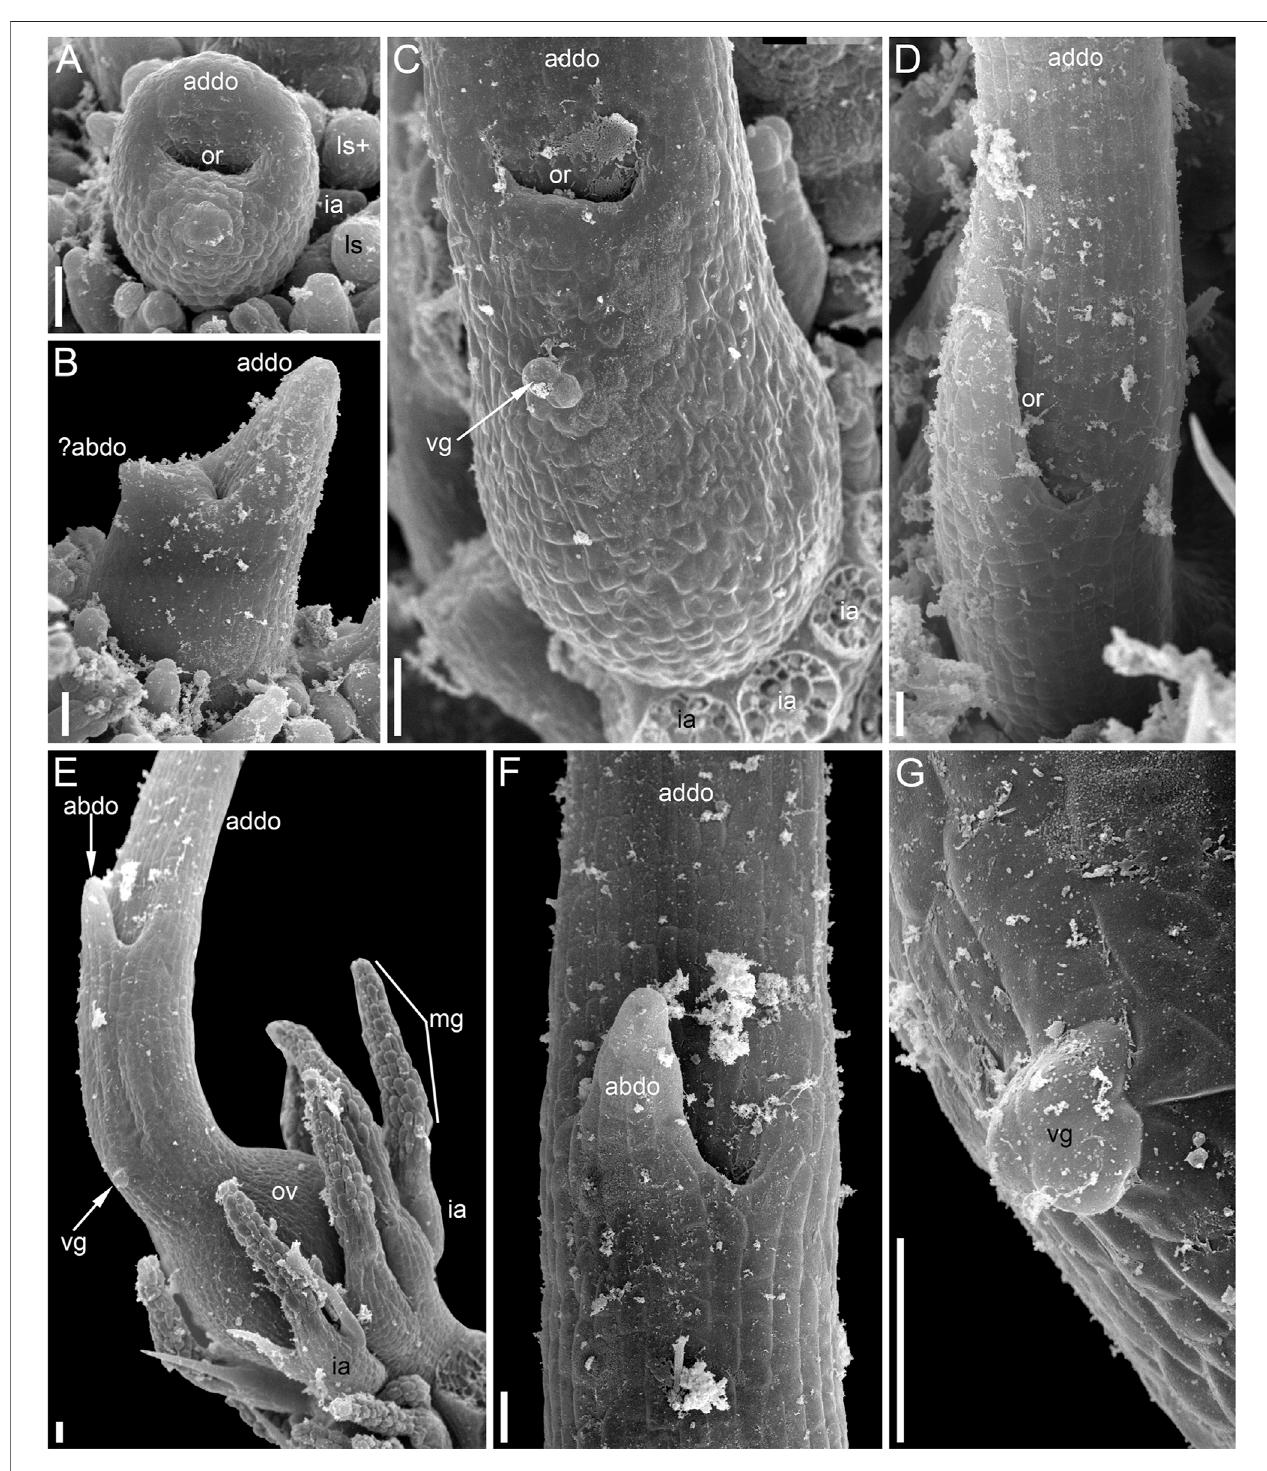
FIGURE 12 | Pistillate reproductive units of Ceratophyllum submersum (SEM). (A – C) Successive developmental stages. (A,C) Adaxial side up; (B) adaxial side right. Each reproductive unit has a pistillate fl ower surrounded by a whorl of involucral appendages. The involucral appendages are removed in (C) , but their scars are visible.In (A,B) ,theinvolucralappendagesandleafysegmentsofstemnodesareyetsmallanddenselycrowded,sothatitisdif fi culttodistinguishthemfromeachother without further dissection in (B) . (D) Detail of anthetic gynoecium seen from the abaxial side; the gynoecial ori fi ce is asymmetrically spaced. (E – G) Anthetic gynoecium with two distal outgrowths of unequal size. (E) General view from lateral side. (F) View from abaxial side; the gynoecial ori fi ce is behind the short abaxial outgrowth. (G) Detail of (E) with vestigial gland. Scale bars = 300 μ m in (A – G) .